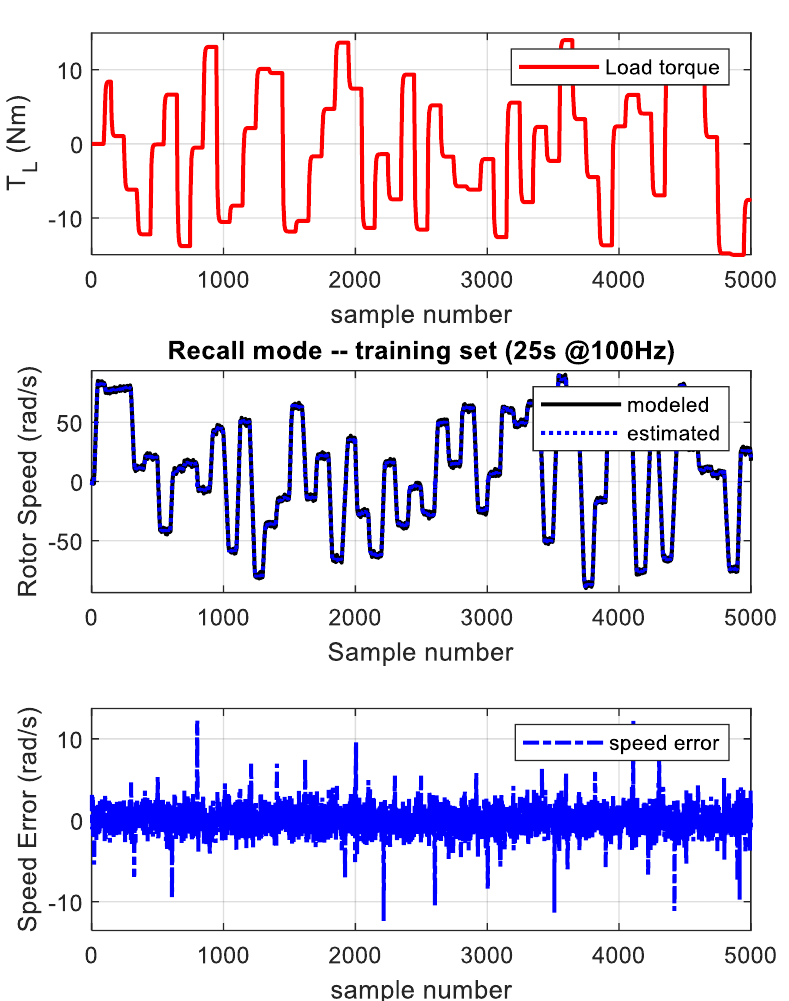
Figure 6. Network performance considering the measured speed and estimated speed.